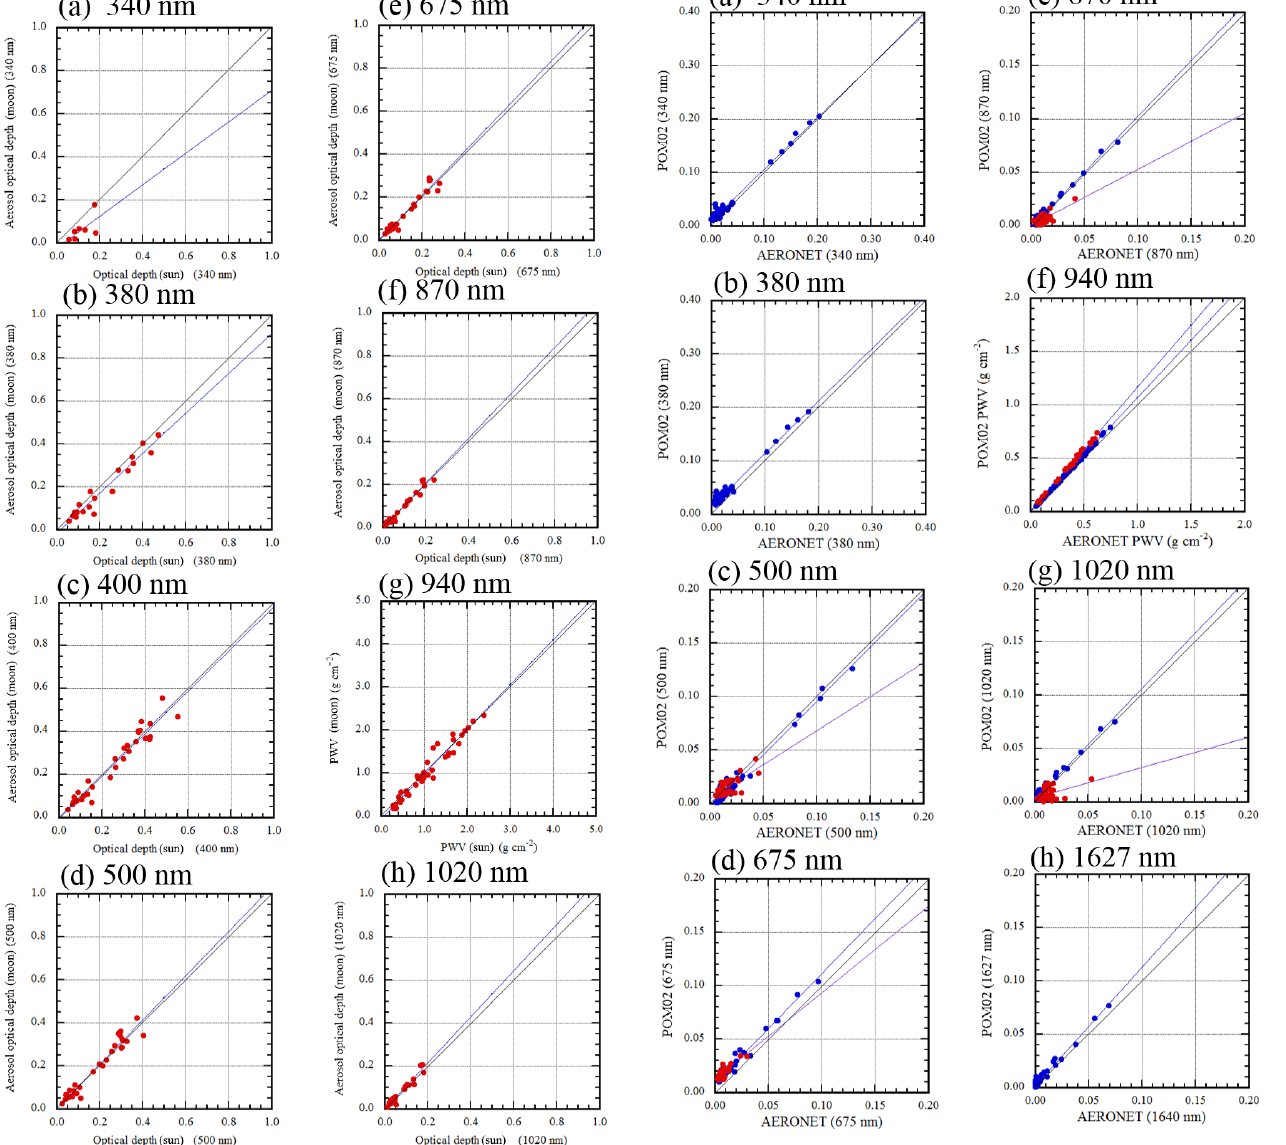
Figure 14. Scatter plot of the aerosol optical depth (precipitable water vapor) from the Sun and the moon: (a) 340nm AOD,